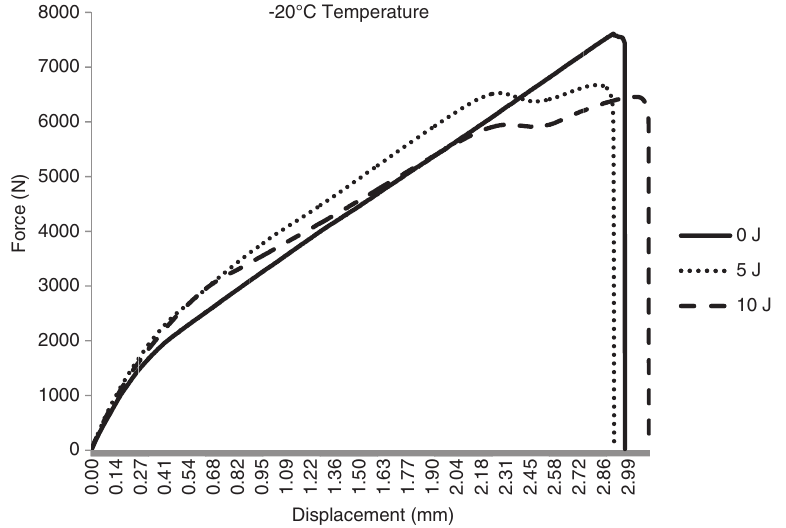
Figure 5: Effects of different impact energy values on load-displacement response at the -20 ° C temperature level.